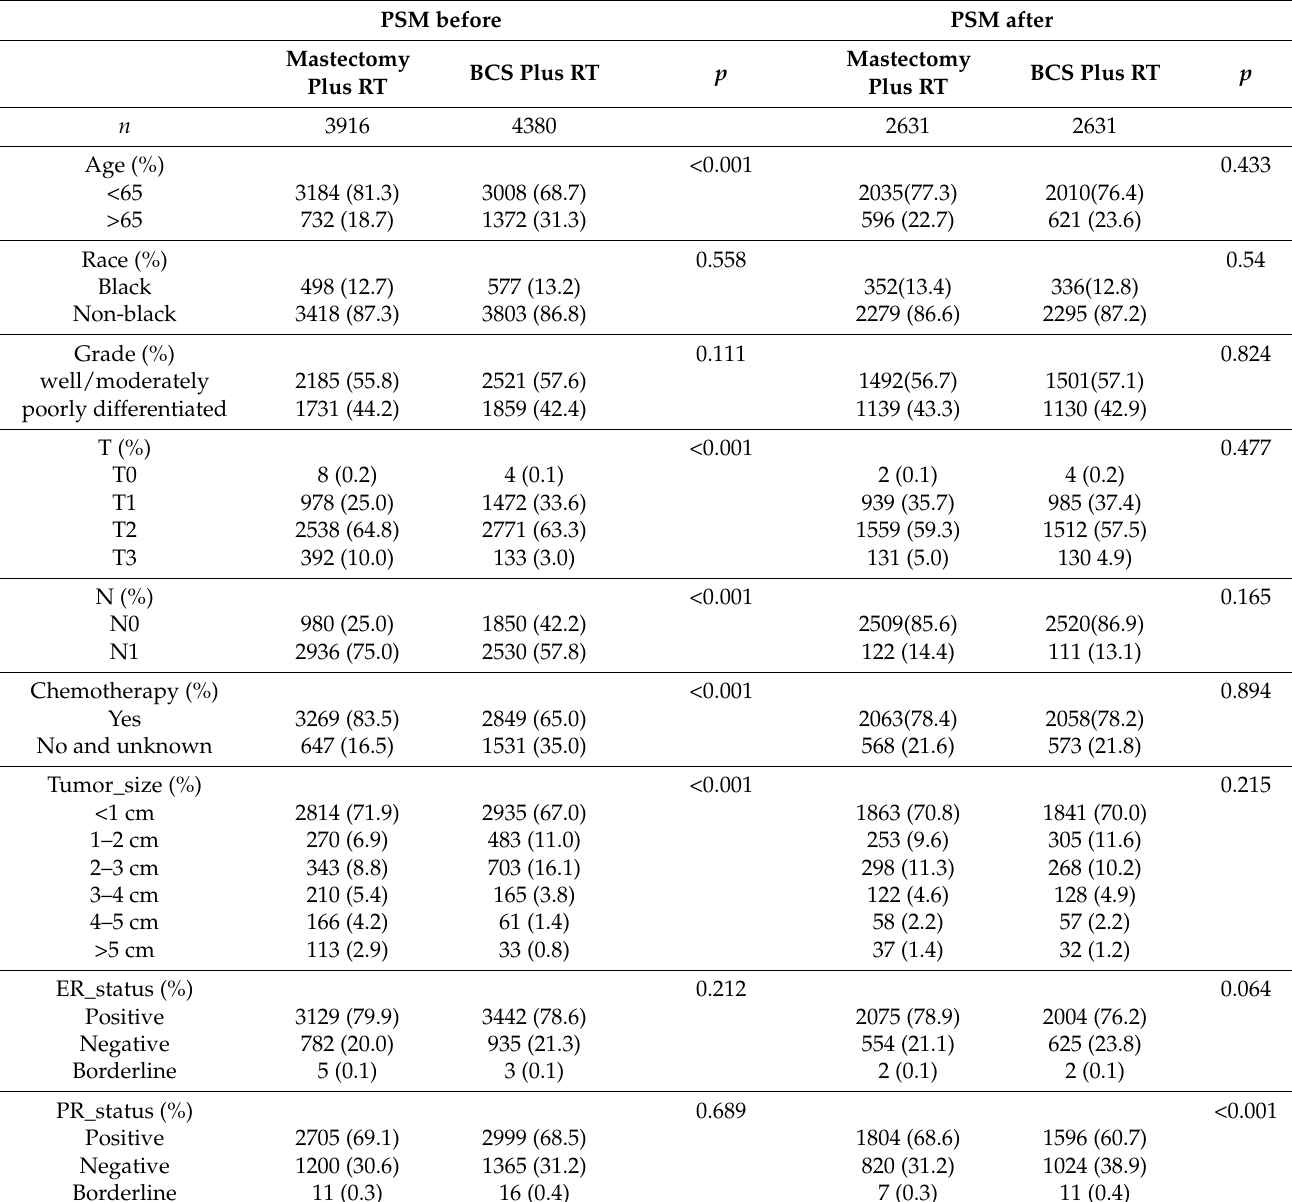
Table 2. Clinical characteristics of patients for stage II before and after propensity score matching